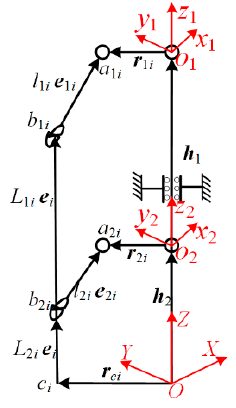
Figure 3. Vector diagram of a closed kinematic chain.